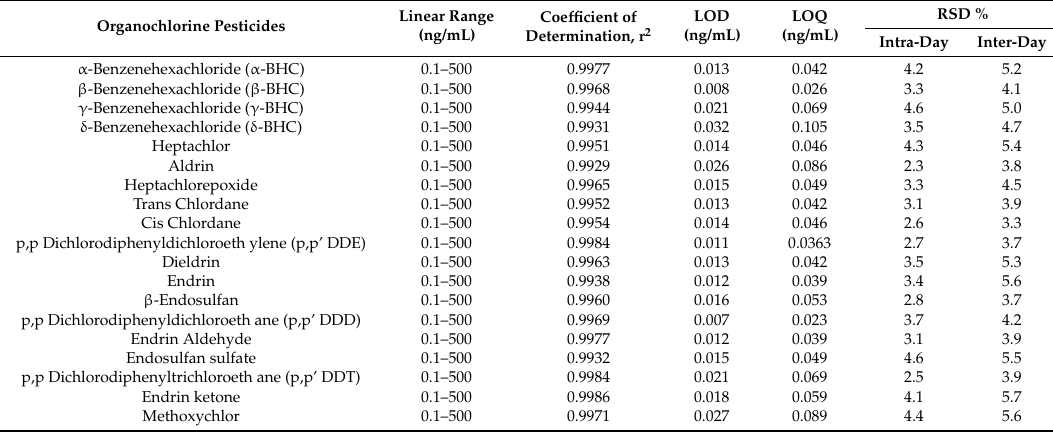
Table 2. The performance characteristics of the proposed FPSE/GC-MS analytical